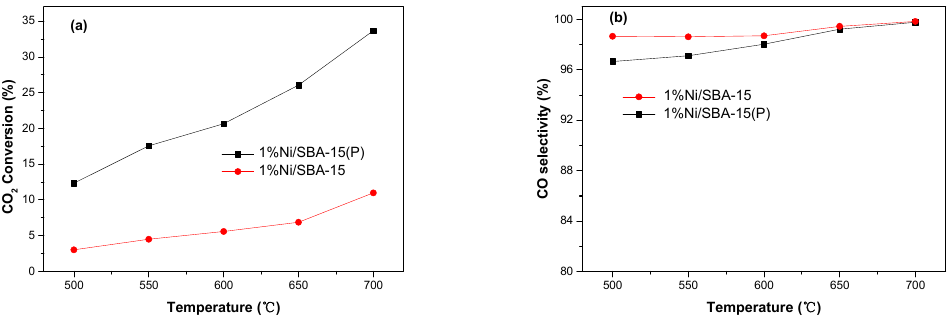
Figure 5. The catalytic performances of 1%Ni/SBA-15 and 1%Ni/SBA-15(P) catalysts in the RWGS reaction: ( a ) CO 2 conversion, ( b ) CO selectivity.